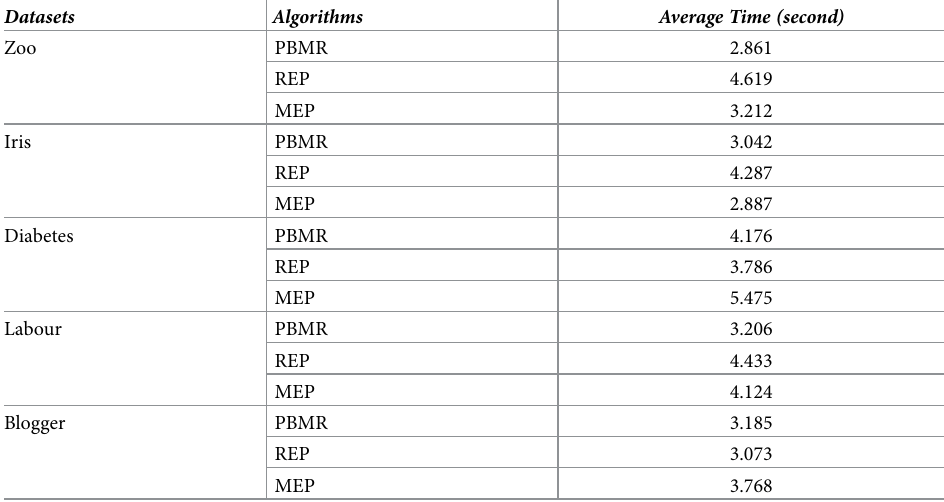
Table 6. Time taken by PBMR, REP, and MEP to perform the pruning process. Datasets